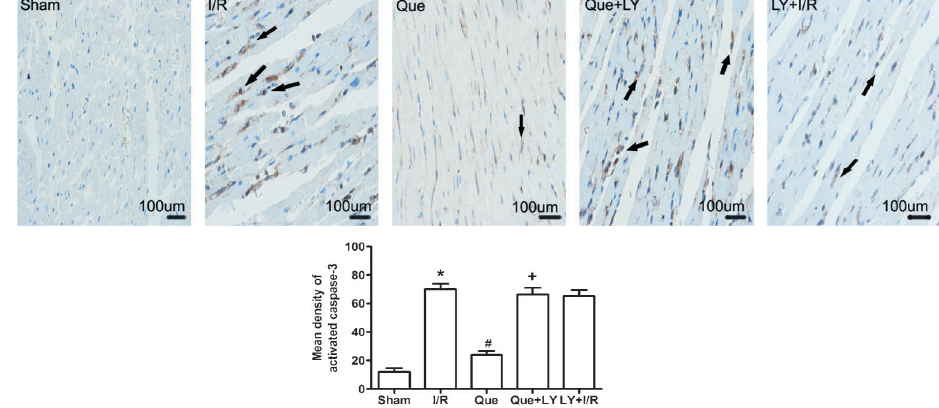
Figure 3. Immunohistochemical staining for activated caspase-3 in the myocardium after I/R injury. Arrows indicate the positive expression of activated caspase-3. Data are reported as means±SD. Que: quercetin; I/R: ischemia/reperfusion; LY: LY294002. *P , 0.05 vs sham group, # P , 0.05 vs I/R group, + P , 0.05 vs Que group (one-way ANOVA followed by the Bonferroni test).